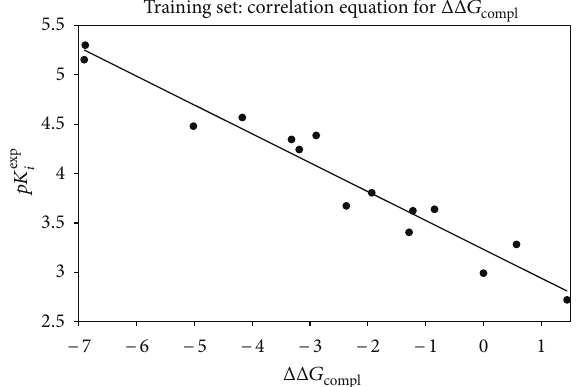
Figure 3: Plot of the correlation equation between 𝑝𝐾 exp 𝑖 and relative complexation Gibbs free energy of the training set.